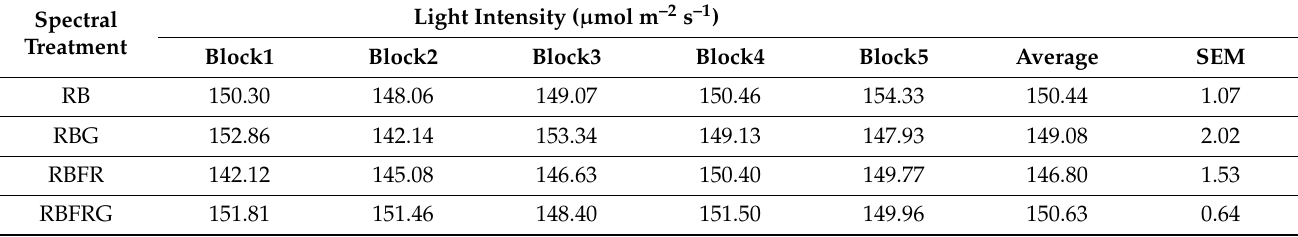
Table A1. Total photosynthetically active radiation (PAR; 400–700 nm) measured in five replicates for the four spectral treatments in Experiment